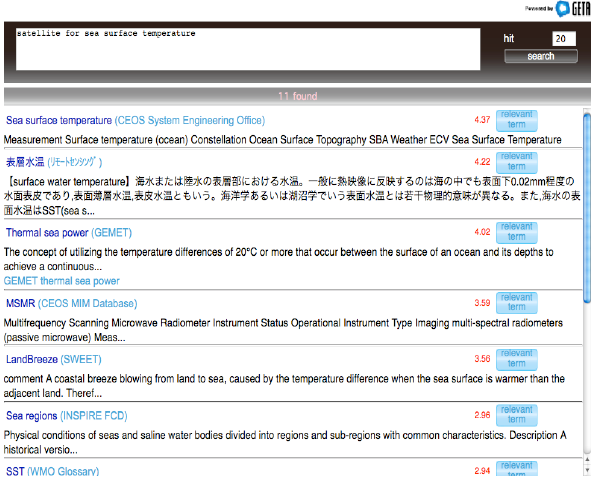
Figure 2. Reverse Dictionary, which retrieve multi data